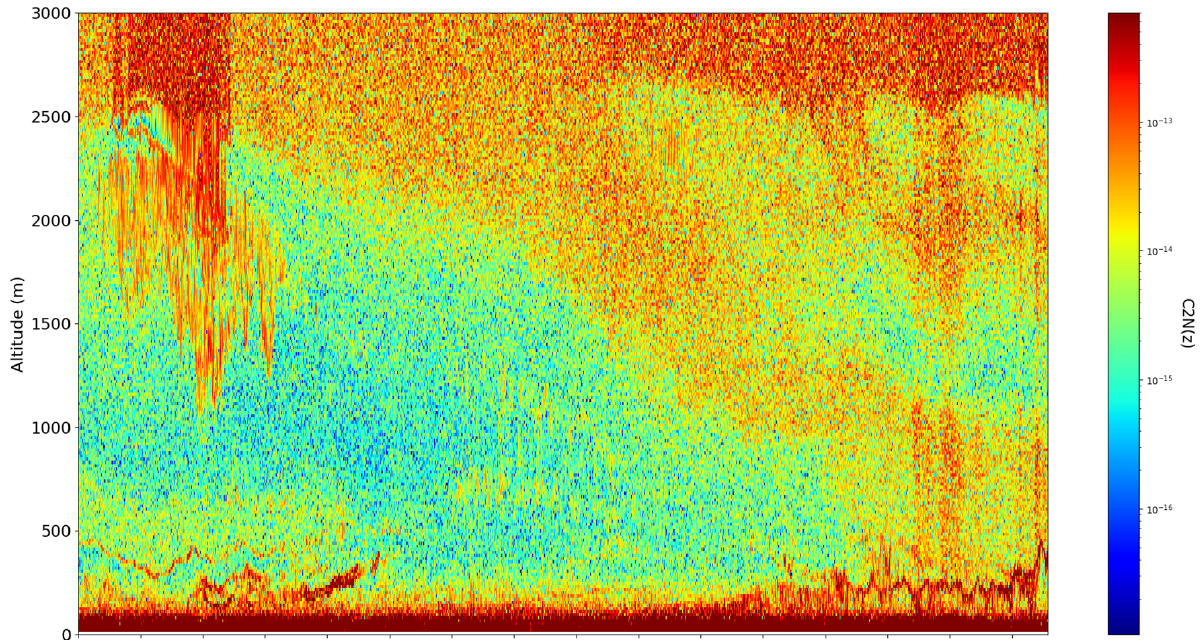
Figure 11. C (cid:2898)(cid:2870) timeseries, λ = 1064 nm , Gala ț i, Romania, 22 December 2021. Figure 11. C 2 timeseries, λ = 1064 nm, Galat N